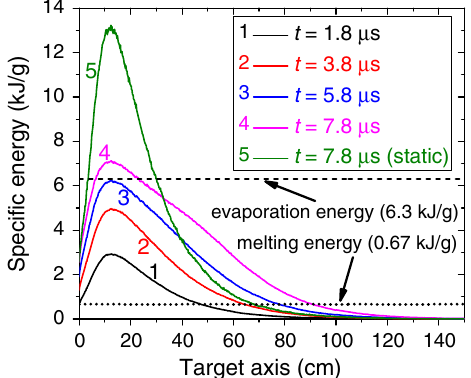
FIG. 5. Accumulated specific energy along the target axis at t ¼ 1 . 8 , 3.8, 5.8, and 7 . 8 μ s. Note that the total specific energy at t ¼ 7 . 8 μ s in the static approximation is also shown in curve 5. The energy lines implying evaporation and melting are shown in the